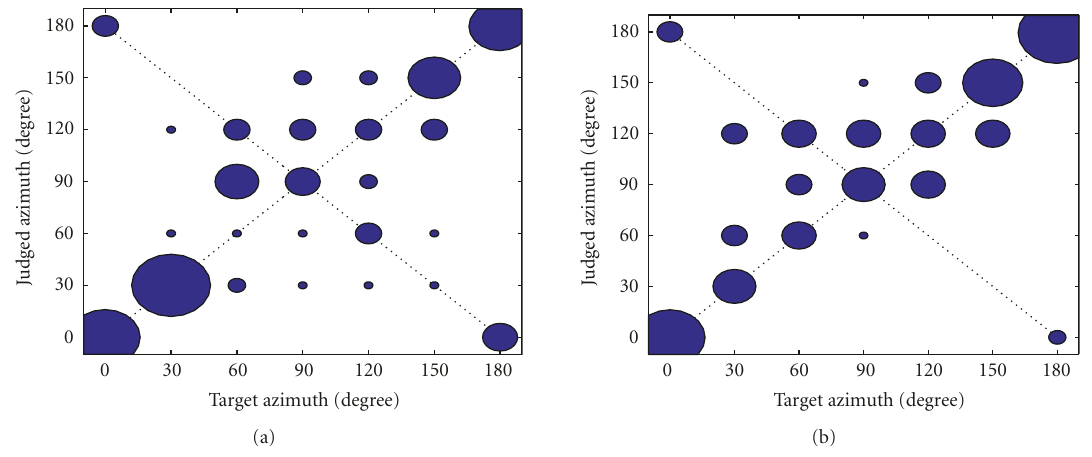
Figure 8: Results of the subjective localization test of azimuth. (a) Fullband CCS. (b) Bandlimited